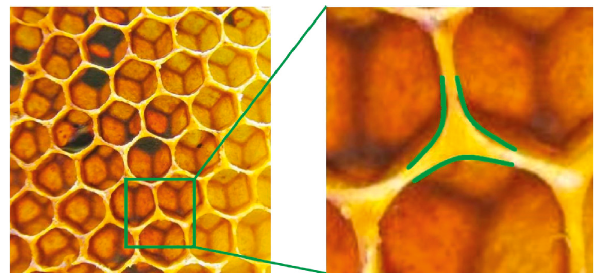
Figure 1: Actual honeycomb